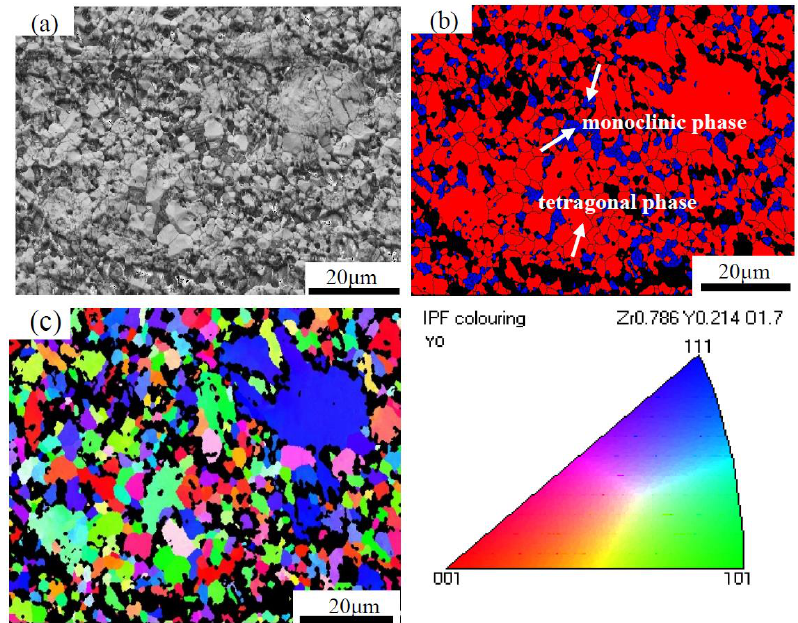
Figure 11. ( a ) SEM images, ( b ) EBSD phase maps of cross-sections of the top coating after 1550 °C/100 h thermal exposure and ( c ) orientation maps, Y-direction. (Tetragonal phase is meant as a group of t, t′ and t″ phases). Table 2. The microstructure parameters of coatings before and after thermal treatment. Coating